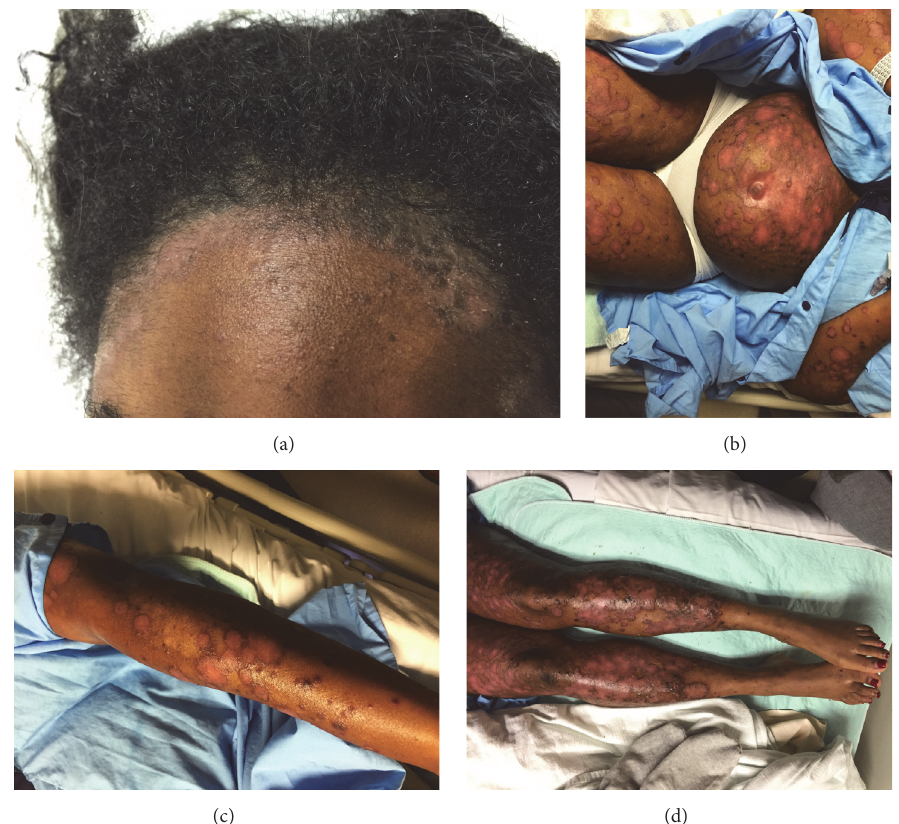
Figure 1: Psoriasis herpeticum. Erythematous scaly plaques with peripheral hyperpigmentation involving the (a) face, scalp, (b–d) torso, and extremities, with scattered ∼ 1cm erosions.